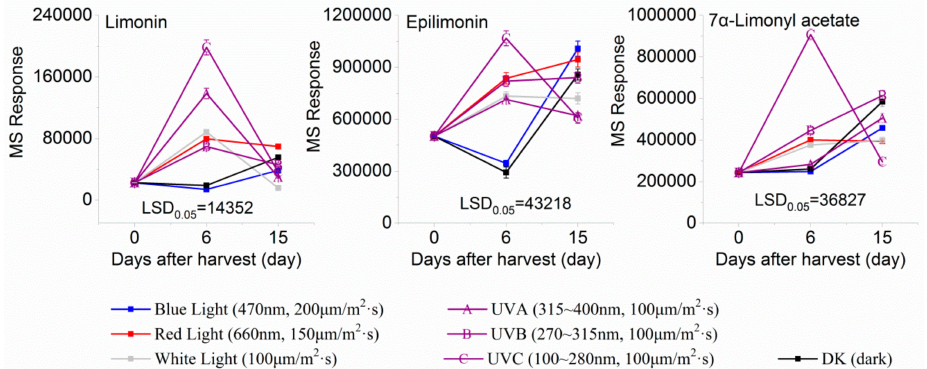
Figure 4. MS response of limonoids in the segments of Newhall navel orange during light irradiation and during the removal period.